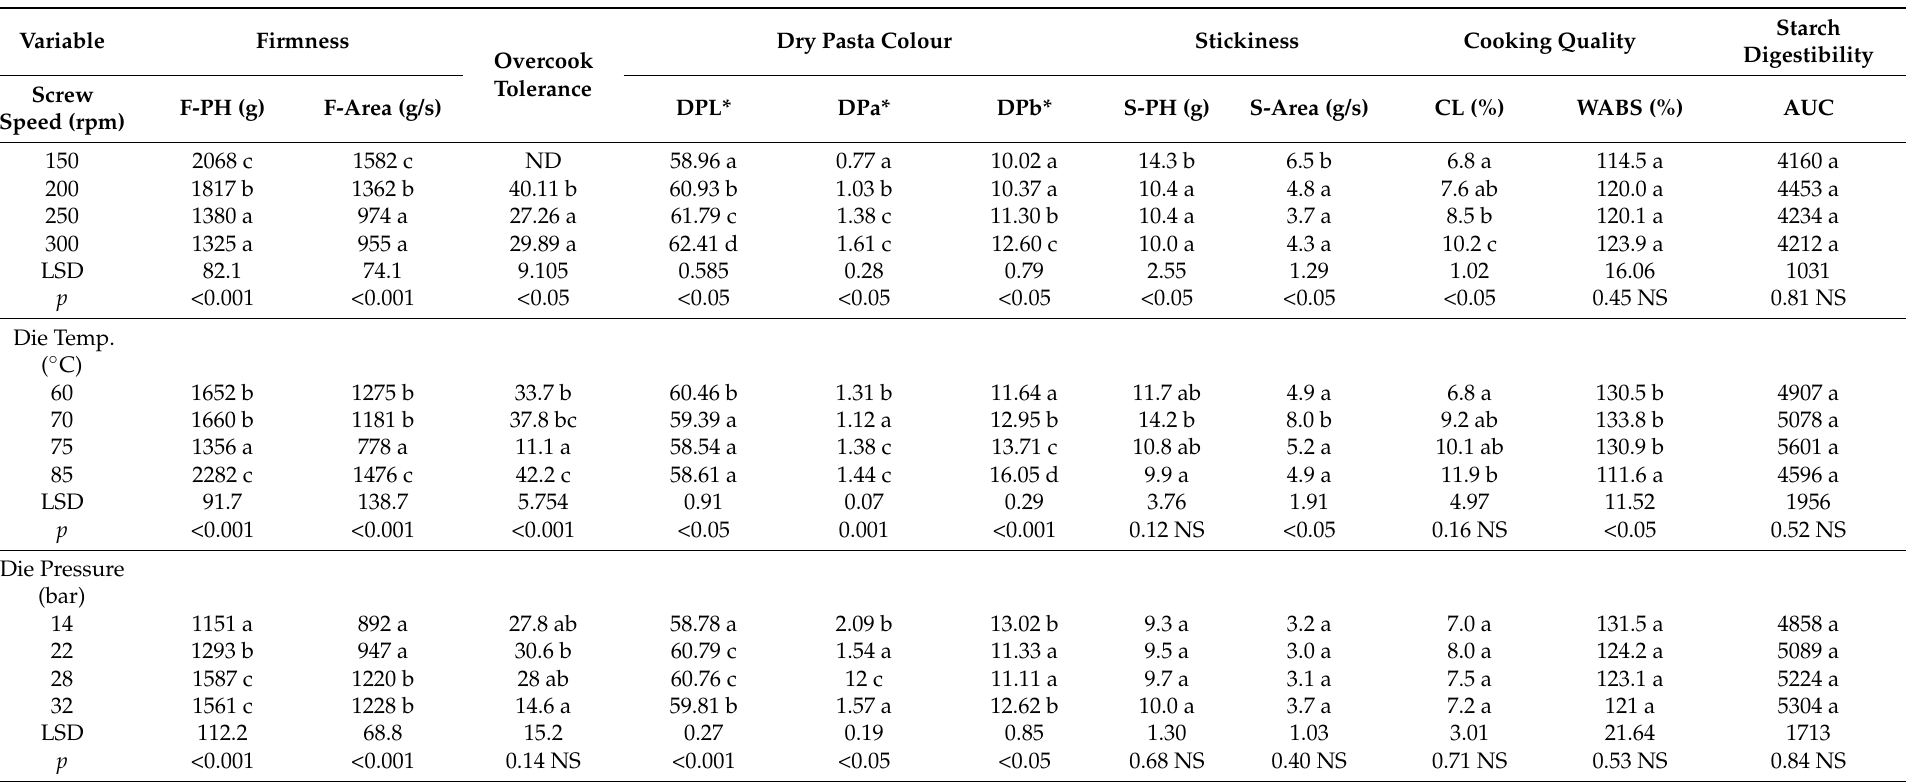
Table 3. Effect of pasta extrusion parameters (screw speed, die temperate and pressure) on pasta technological attributes and the extent of starch digestion. A twin-screw pasta extruder was